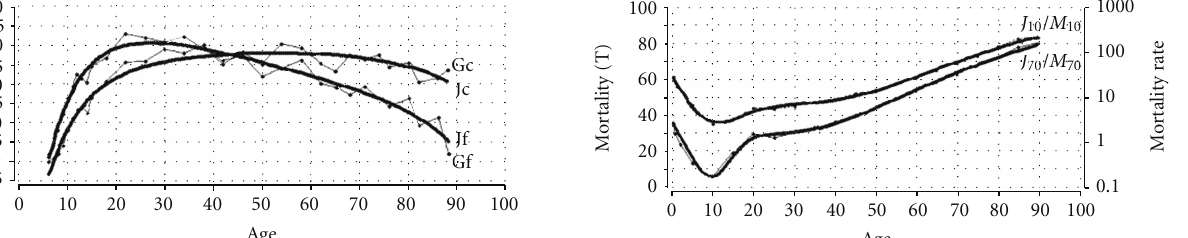
Figure 7: Simulation of U.S. mortality in the years 1910 and 1970 (dotted: M 10 , M 70 ) with the Janus model (bold: J 10 , J 70 ) [11,